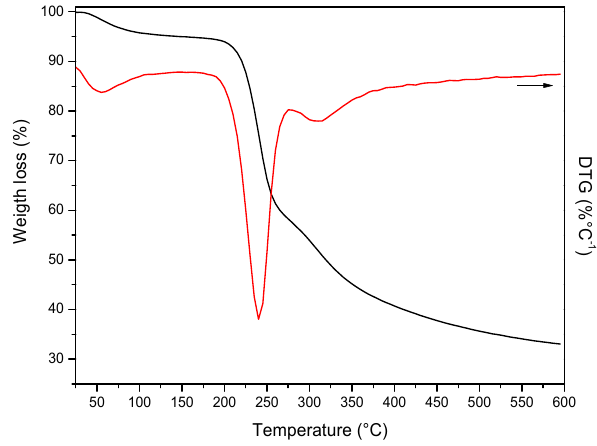
Figure 8. Thermogravimetric curves of Camb6 exopolysaccharide.